Question: Sum up the contents of this chart in one sentence.
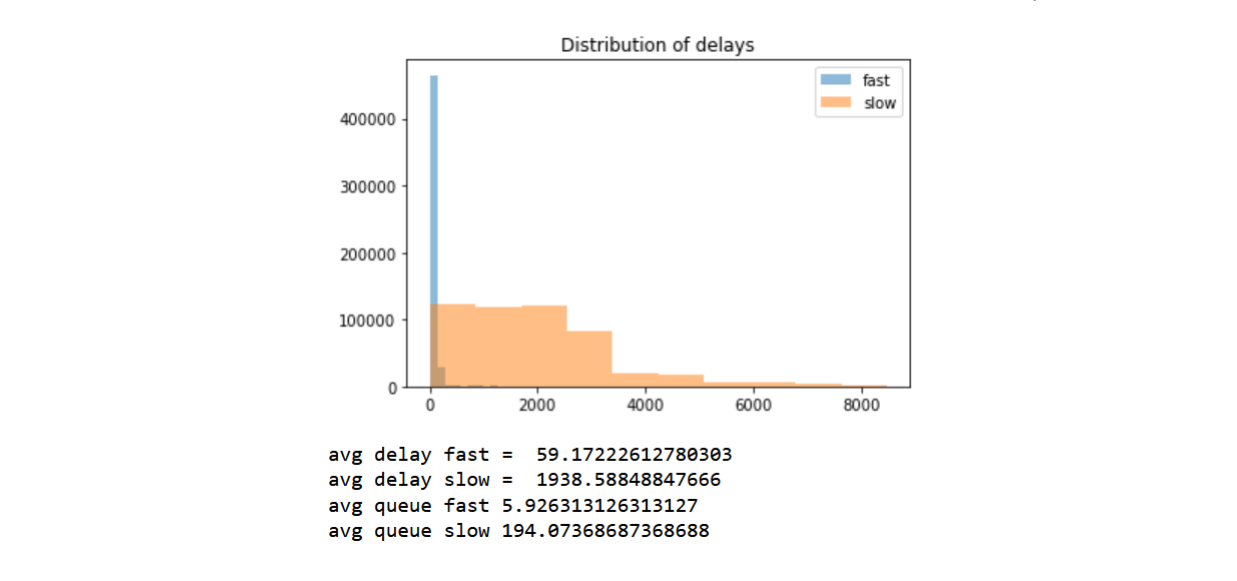
Answer: Histogram of fast and slow delays (in number of server steps) for a uniform sampling scheme.